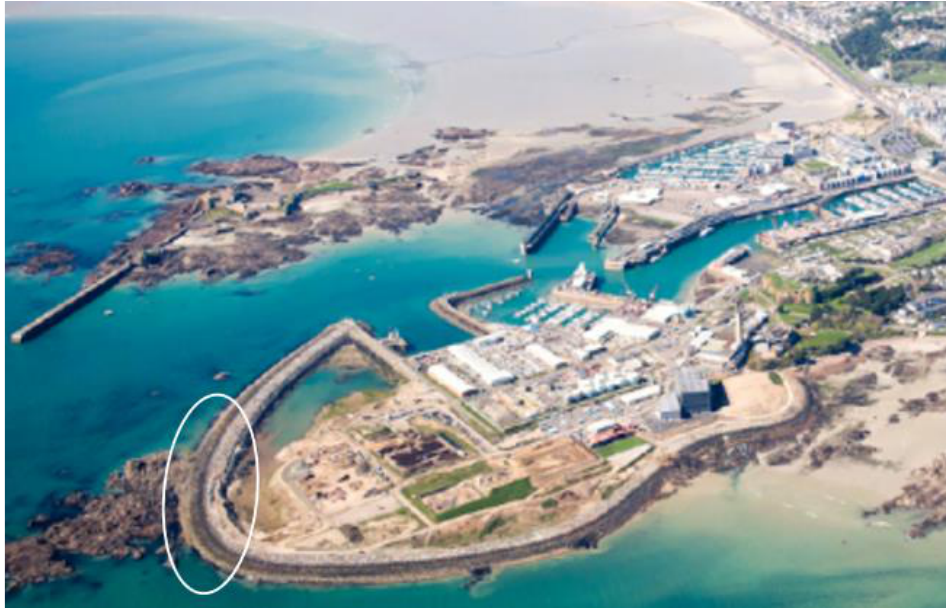
Figure 7. La Collette reclamation, view towards North-West.